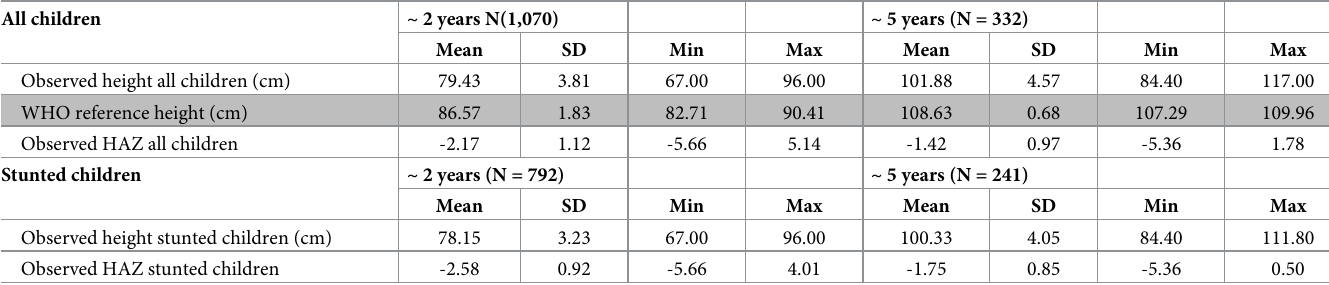
Table 1. Summary statistics on child growth at around 2 years and 5